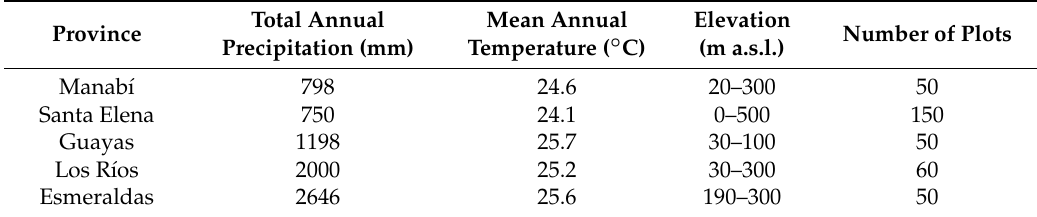
Table 1. Geographic location and general conditions of the silvopastoral systems under study in the coastal lowlands of Ecuador.